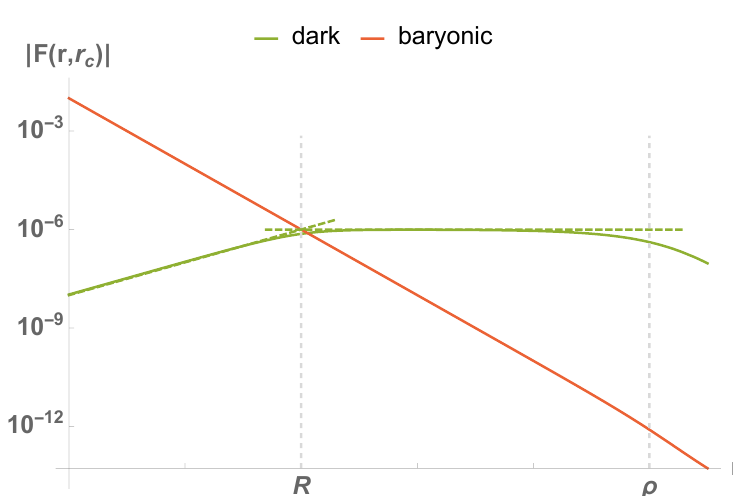
Figure 3. This log-log plot shows the force along the brane as a function of r (in units of R ). The \dark" force (due to a point source with mass M on the parallel brane), expressed in units of GMm (which is just f from (A.1)), is plotted as the green solid curve. The green dashed curves 2 R 2 are its asymptotes in regimes (III) and (II), given by r and 1 . The red curve is the \baryonic" r c r c force (due to a point source on the same brane), expressed in the same units. The \baryonic" force is obtained numerically from (A.3), with F B = (cid:0) @ V B (see also footnote 18). We did not plot the @r asymptote (cid:24) 1 =r 2 , because in the regime r (cid:28) (cid:26) it is indistinguishable from F B . The point mass, which gives rise to F B , is chosen such that both forces are of the same order at r = R . We chose the ratio r c =R = 10 6